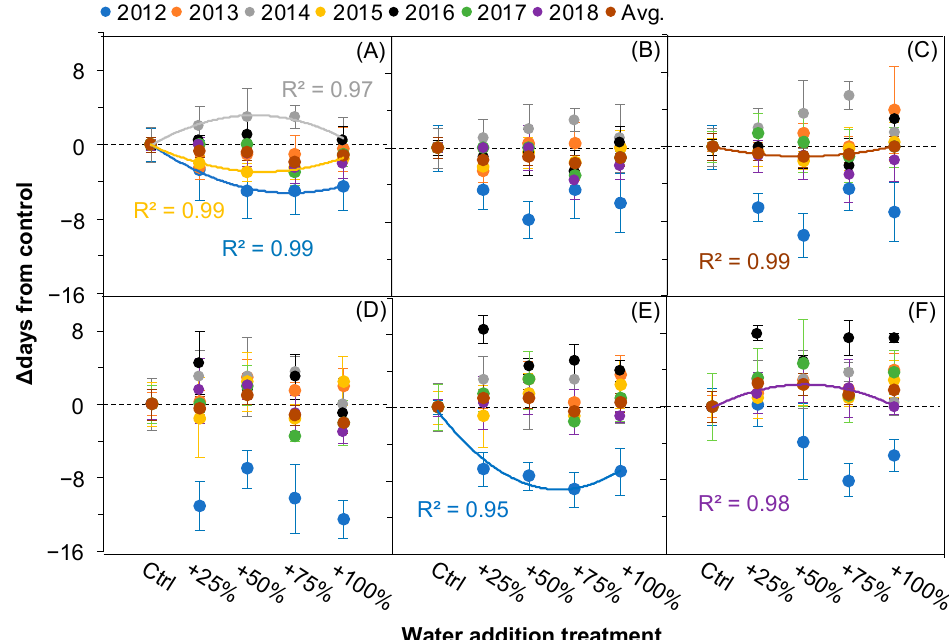
Figure 7. Correlations between the amount of water added (Control (Ctrl), +25, +50, +75%, +100%) and the relative changes ( △ days) in the fruiting events of Nitraria tangutorum . ( A ) OFS, onset of fruit setting; ( B ) PFS, peak of fruit setting; ( C ) EFS, end of fruit setting; ( D ) OFR, onset of fruit ripening; ( E ) PFR, peak of fruit ripening; ( F ) EFR, end of fruit ripening. Avg. represents average values over the period from 2012 to 2018. The solid lines indicate p ≤ 0.05.